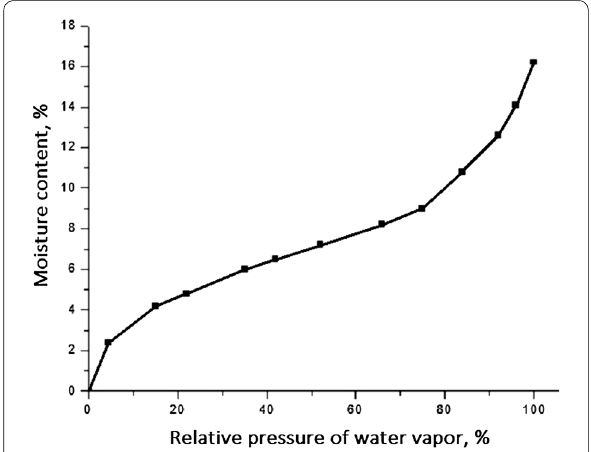
Fig. 2 Experimental adsorption isotherm of water vapor on cotton